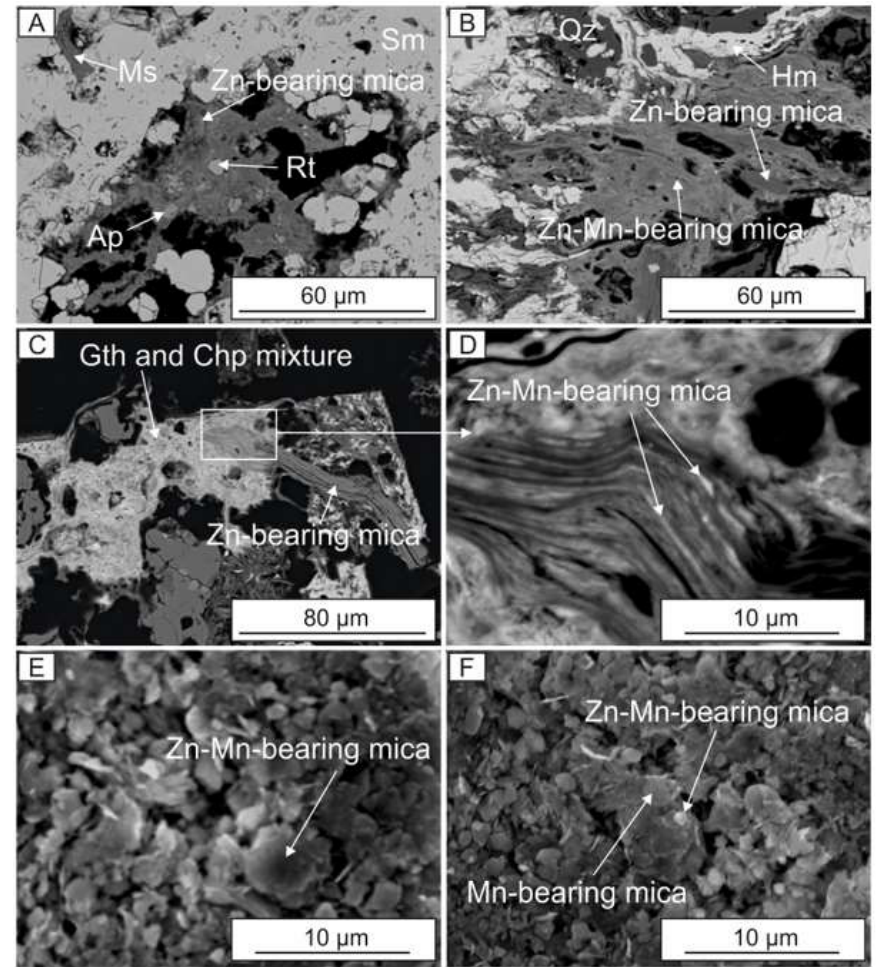
Figure 5. Secondary and backscattered electron (BSE) images of Zn-bearing and Zn-Mn-bearing micas in the Cristal samples. ( A ) A cavity in smithsonite (Sm) filled by a clayey mixture, which surrounds the Zn-bearing mica remnants, as well as rutile (Rt) and apatite (Ap) crystals (sample CR03-3); ( B ) Hendricksite surrounding a Zn-bearing mica in a hemimorphite (Hm)- and quartz (Qz)-rich sample (CR13-6); ( C ) Goethite (Gth) and chalcophanite (Chp) surrounding a Zn-bearing mica with possible Zn-Mn-bearing layers; ( D ) (sample CR13-7); ( E , F ) Possible Mn-(hydr)oxides-free powders from the CR07-11_5/5000 sample showing the occurrence of hendricksite